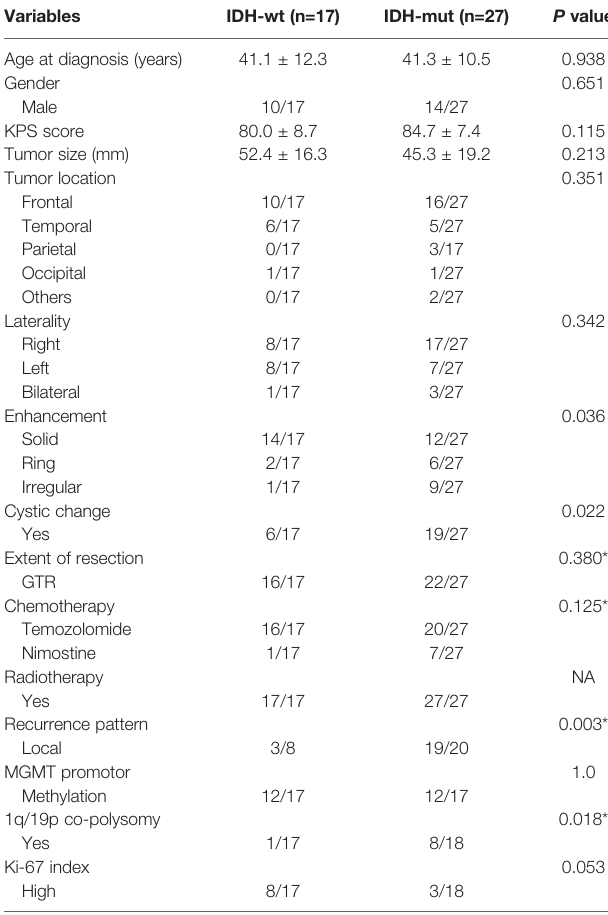
TABLE 3 | Comparisons of baseline characteristics between IDH-wt and IDH- mut long-term survivors.